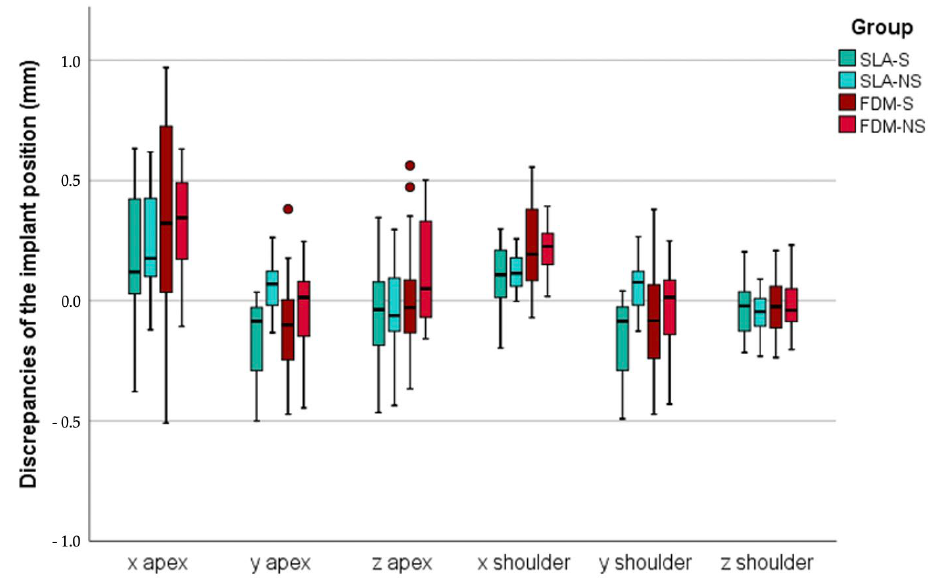
Figure 3. Boxplots of minimum, maximum, interquartile range, median, and outliers for discrepancies of the implant position at implant apex and shoulder level. SLA: stereolithography, FDM: